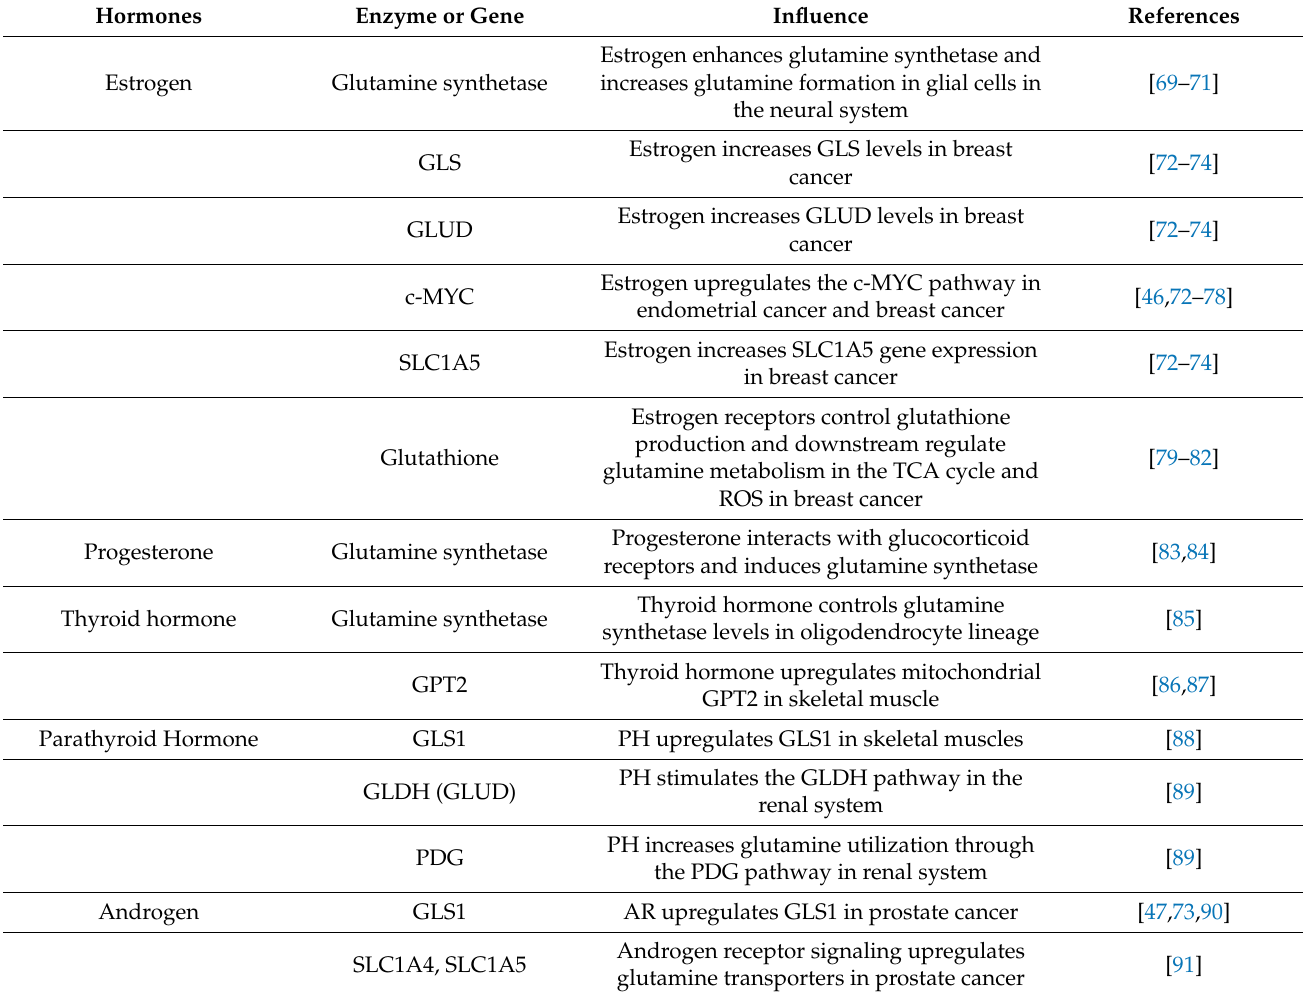
Table 1. Effects of regulation of hormones on glutamine